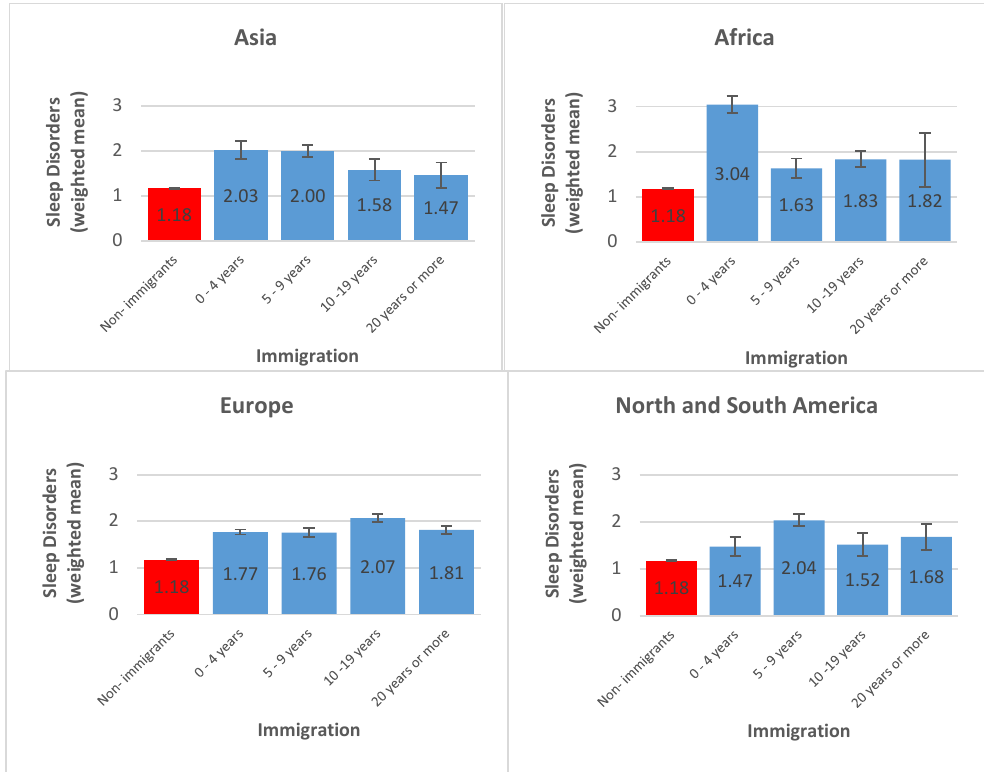
Figure 2. Sleep disorders stratified by continent of origin and years since immigration. Total population N = 17,968, immigrant population n = 3406, non-immigrant population n = 14,562, Europe n = 2927, North and South America n = 231, Africa n = 167, Asia n = 75, Australia and Oceania were omitted due to n = 6.